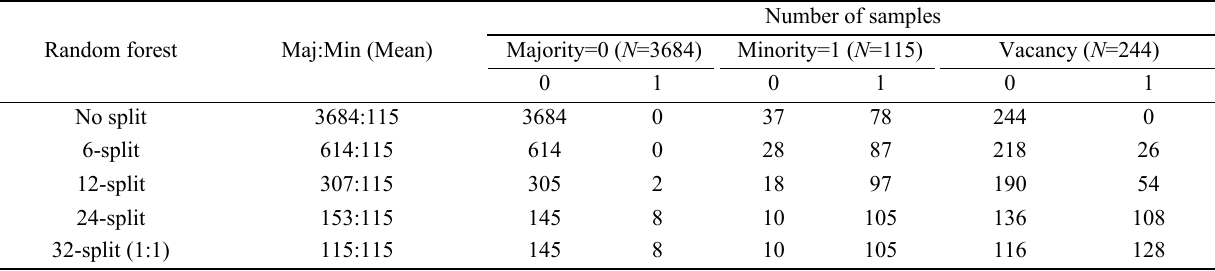
Table 10 Result from RF predictors using different splitting strategies (910 control variables). Random forest